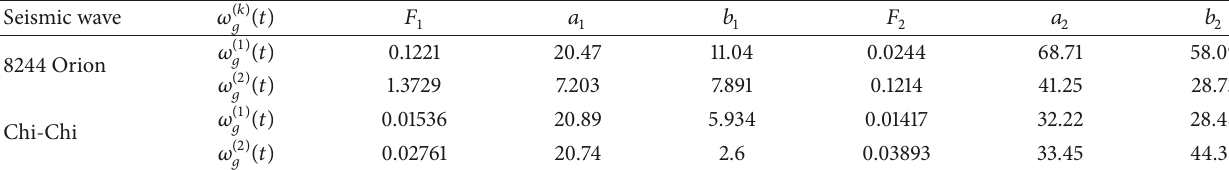
Table 1: Values of parameters 𝜔 (1) 𝑔 (𝑡),𝜔 (2) 𝑔 (𝑡) .